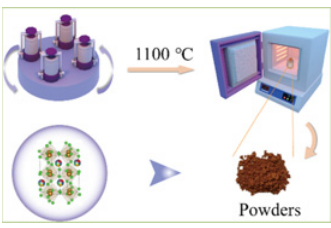
Fig. 1 Preparation of